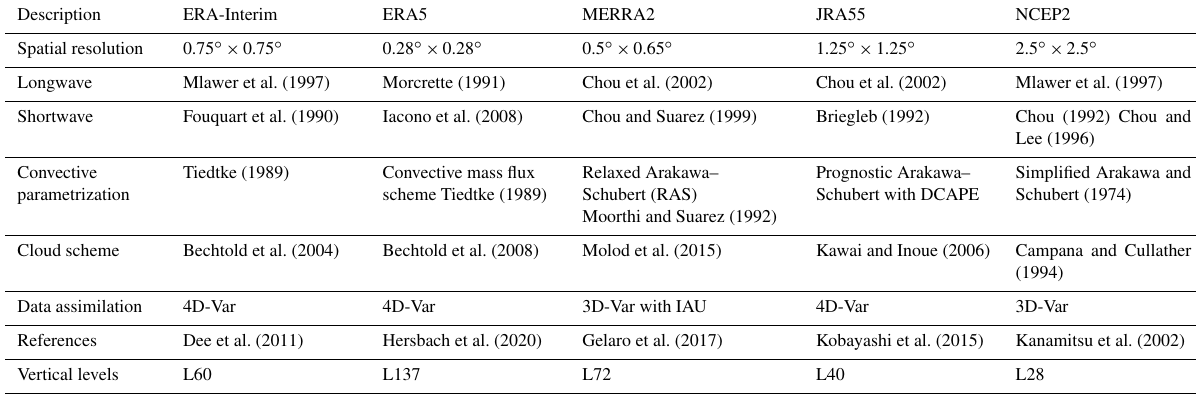
Table 2. Schemes of different reanalysis data used in the present study.